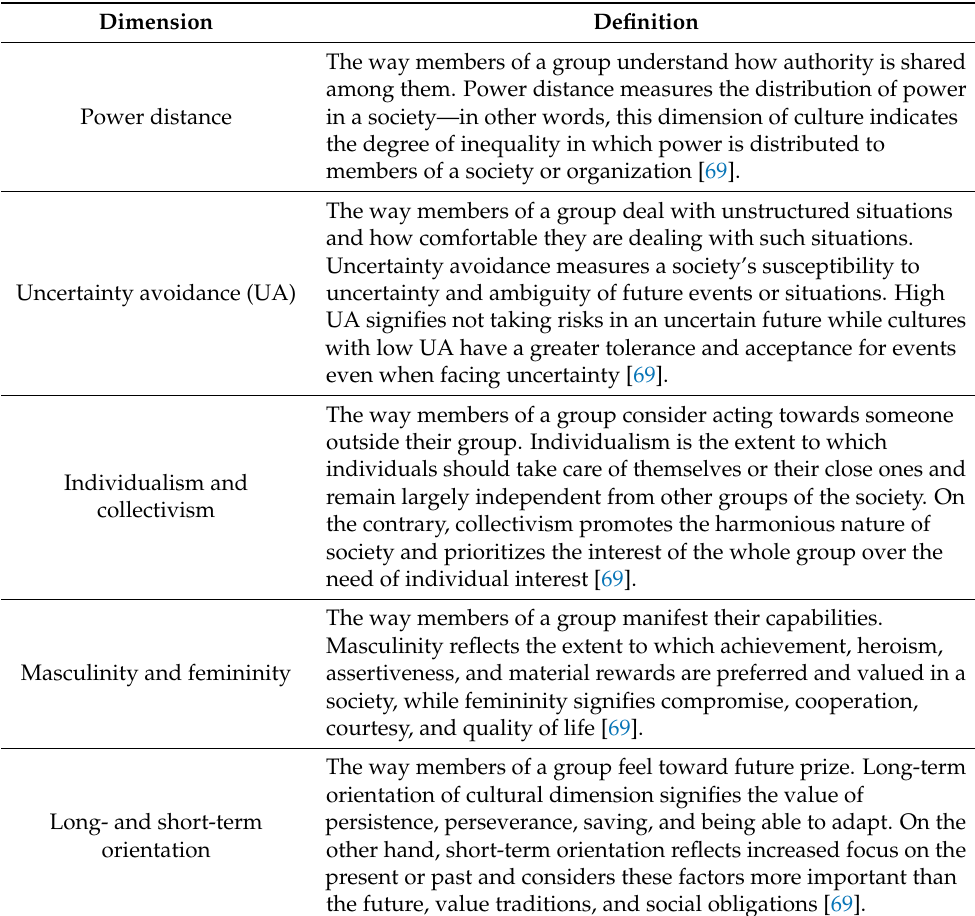
Table 1. Definitions of the Hofstede’s cultural